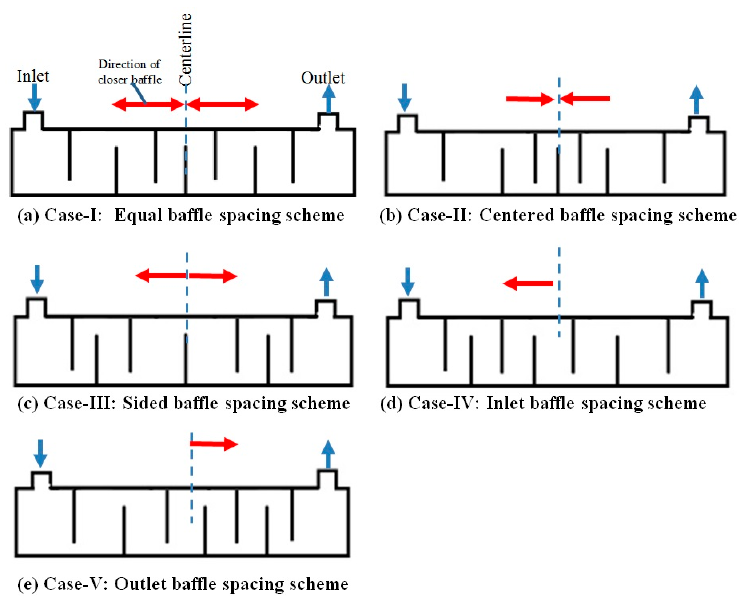
Figure 3. Baffle spacing scheme for all cases. Table 1. The dimensions of baffle spacing lengths for all cases.